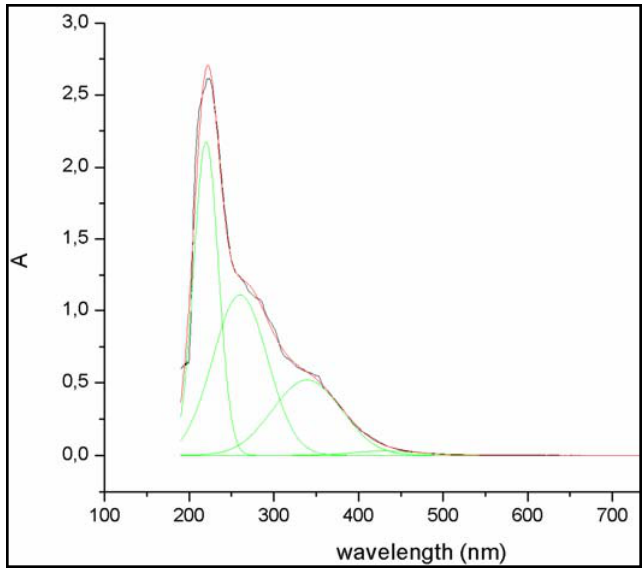
Figure 8. UV-vis absorption spectra of OBMPA in chloroform solution (—), deconvolution of UV-vis absorption spectra of OBMPA into compounds of Lorentzien profile ( −−−